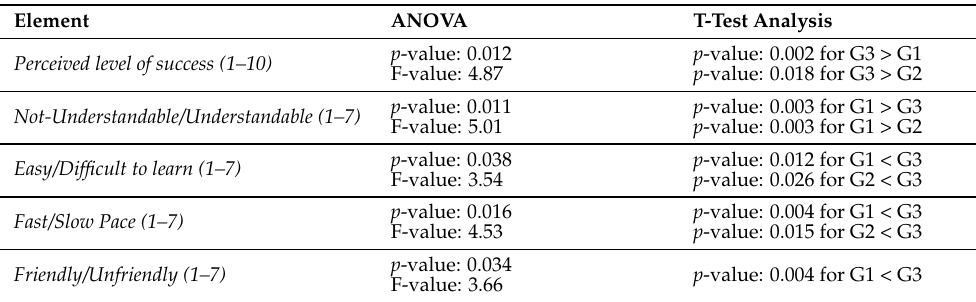
Table 3. Results of the ANOVA and two-sample t -test analysis. G1 is the “Narrative Tutorial Group”, G2 is the “Simple Tutorial Group” and G3 is the “No Tutorial Group”. Element